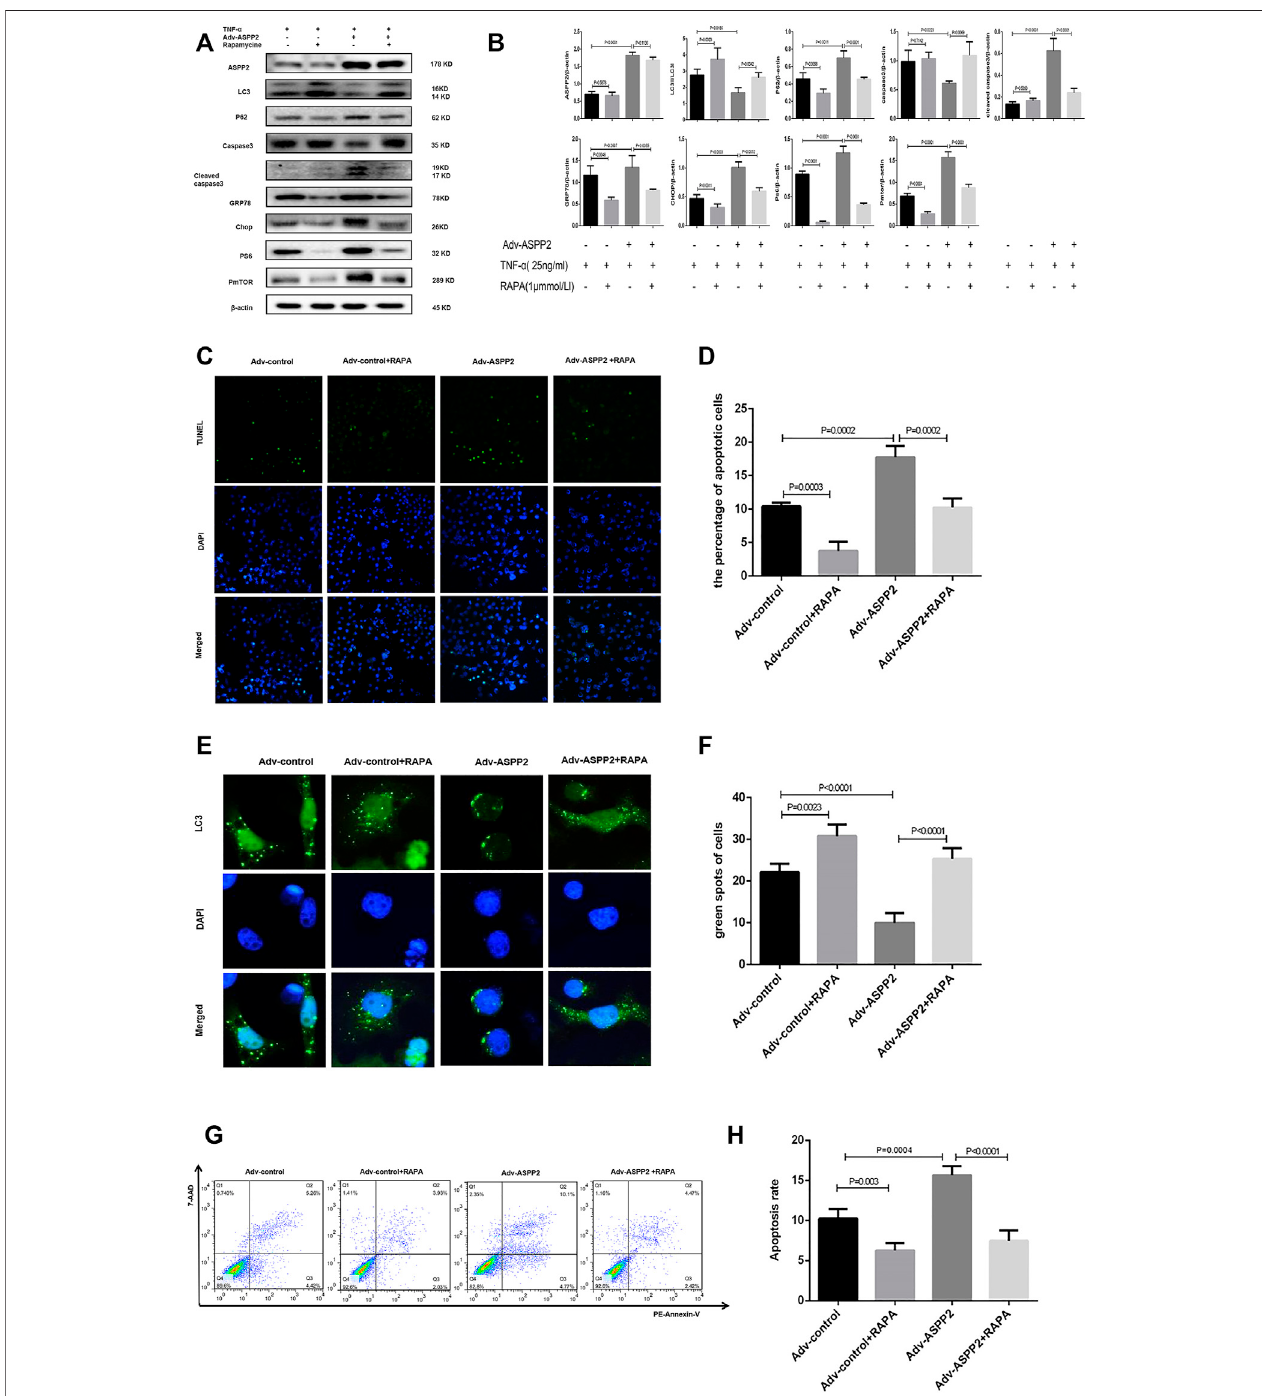
FIGURE7| ASPP2inhibitionpromotedautophagybutsuppressedERS-apoptosisthroughmTORC1pathwayinhepatocyteinjuryinducebyTNF- α .HL7702cells were transfected by Adv-ASPP2 or Adv-control (5 nM), then pretreated by rapamycin (1 μ mmol/L) for 2 h and fi nally induced by TNF- α (25 ng/ml) for 24 h. (A,B) RepresentativewesternblottinganalysiswasconductedofproteinexpressioninHL7702cellsaftertreatment.Quanti fi cationswerenormalizedto β -actinandexpressed asrelativedensity. (C,D) RepresentativeapoptosisimageswerepresentedbyTUNELassay.ThenumberofapoptoticcellswascalculatedusingImageJsoftware. (E,F) AGFP-LC3plasmidwastransfectedintocellsandtherepresentative fl uorescenceimageofcellswasshowed.Thegreenspotsofcellsweremanuallyquanti fi edin fi ve randomly selected areas. (G,H) Representative apoptosis images were showed with PE and 7-AAD reagents by fl ow cytometry. The apoptosis rate was calculated using the proportion of early and late apoptotic cells in total cells.